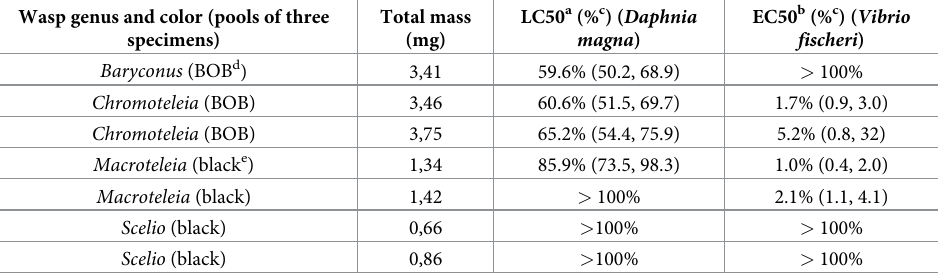
Table 3. Toxicity ( ± C.I.) of extracts of scelionid wasps as determined in acute tests in the bioindicators Daphnia magna and Vibrio fischeri